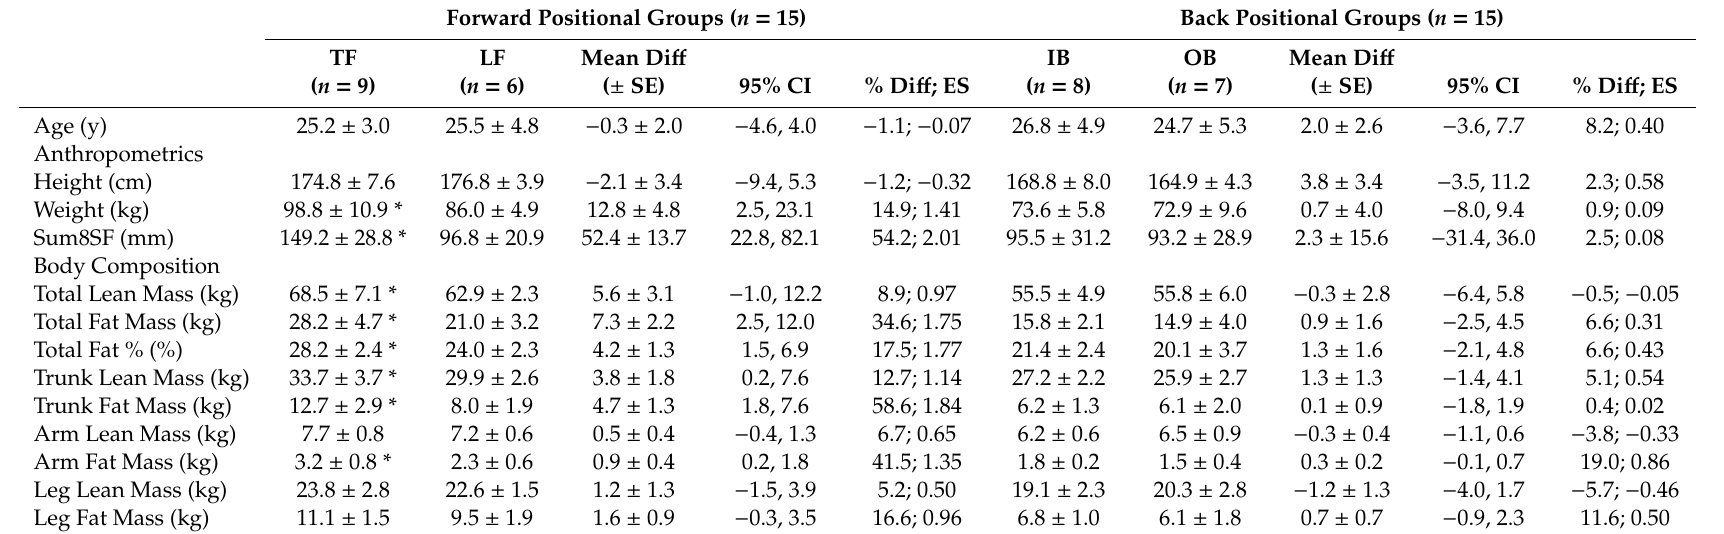
Table 4. Demographics, anthropometrics, total and regional body composition within forward and back positional groups. Forward Positional Groups ( n =